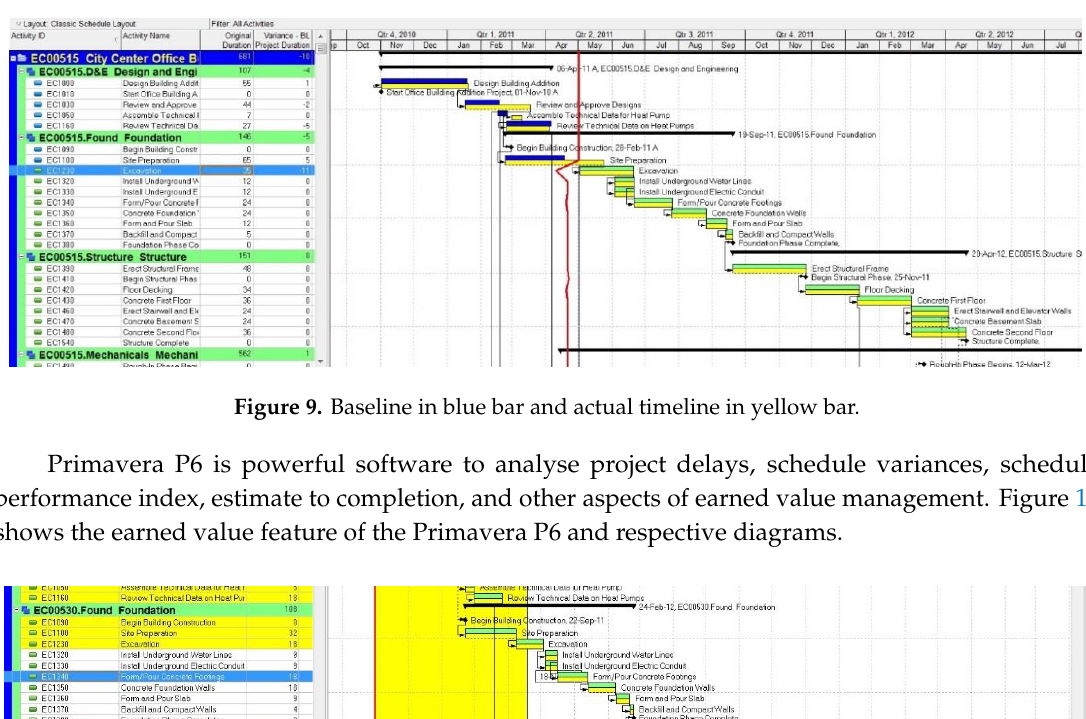
Figure 10. Earned value analysis using Primavera P6.